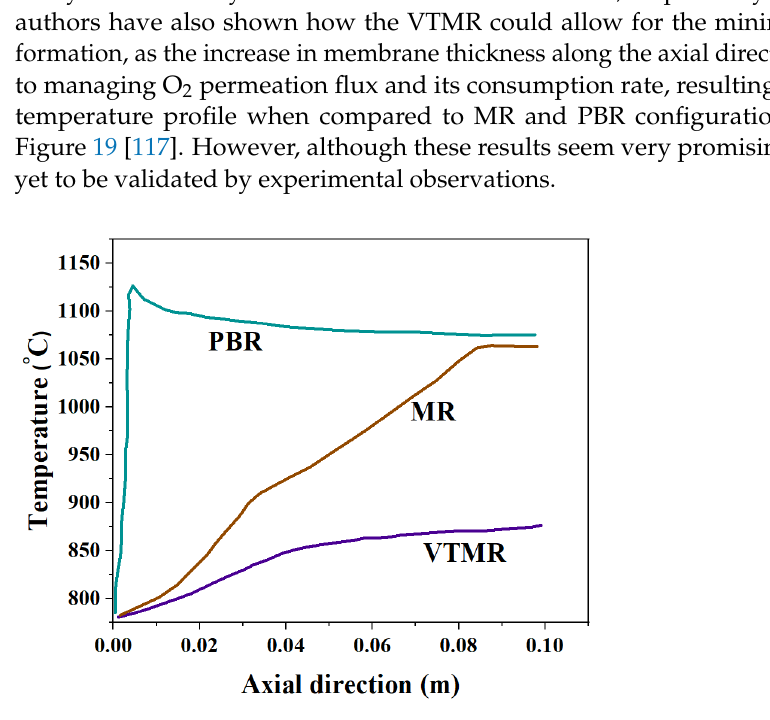
Figure 19. Simulated temperature profiles for PBR, MR and VTMR in adiabatic operation (adapted from [117]). from